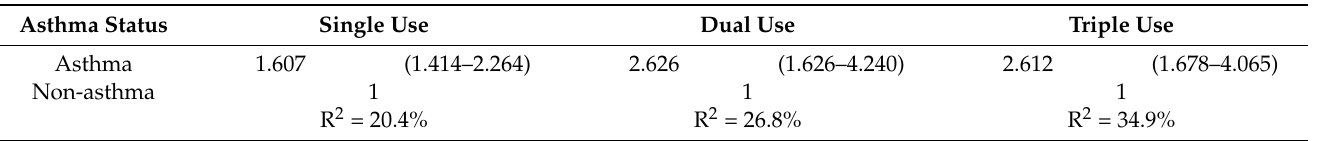
Table 4. Multiple logistic regression model of the association of asthma status with multiple tobacco product